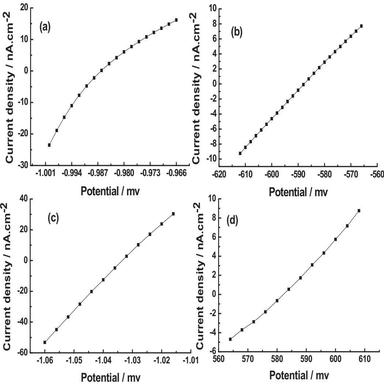
Polarization resistance of DNA (a), DNA-GO@TiO2..ZnO. Ag (b), BSA (c), and BSA– GO@TiO2..ZnO. Ag (d).